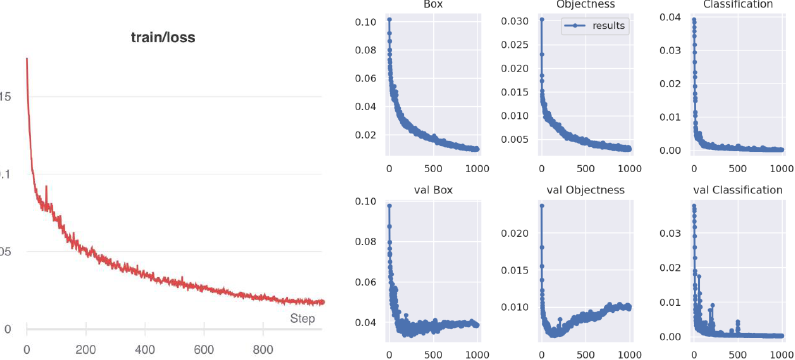
Figure 8. The curve of loss function. Training loss is measured during each epoch while validation loss is measured after each